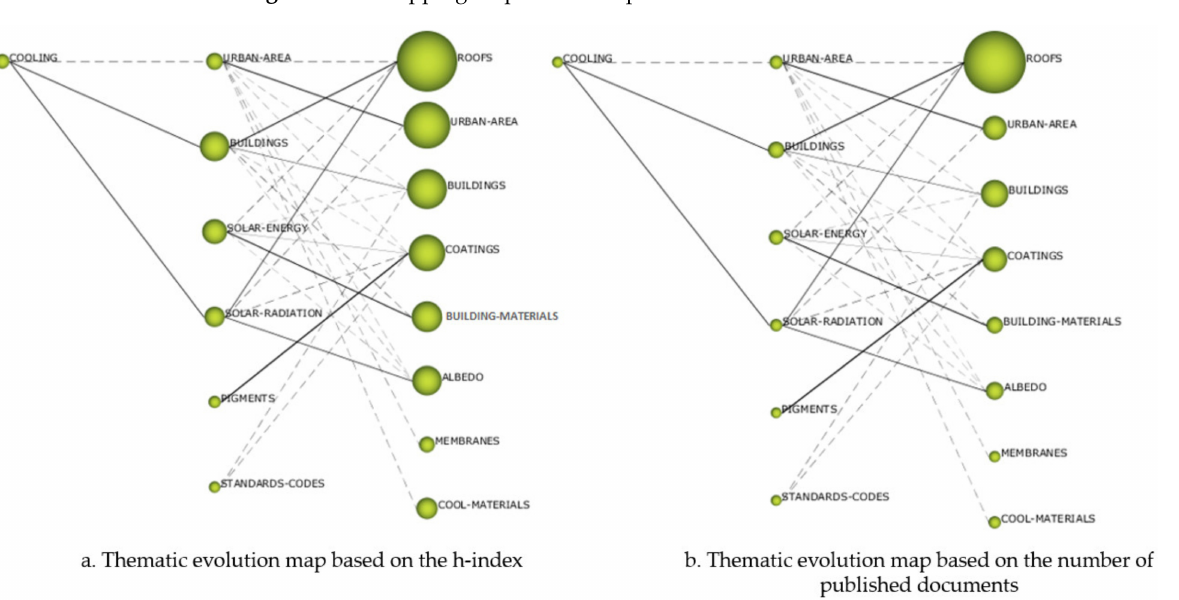
Figure 6. (Thematic evolution map according to the h-index ( a ) and the number of published documents ( b